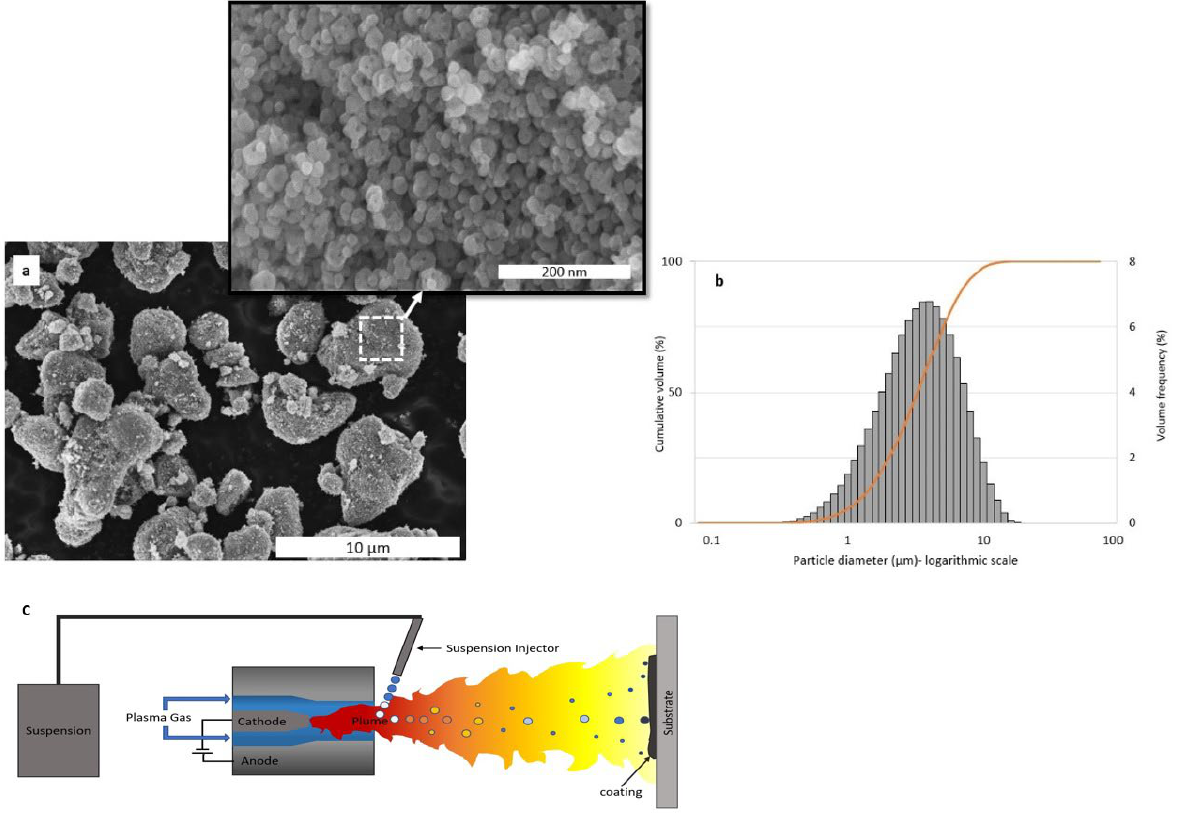
Figure 1. ( a ) SEM micrograph of the TiO 2 powder, ( b ) agglomerate size distribution of the TiO 2 aqueous suspension, ( c ) schematic of the 3 MB suspension plasma system.